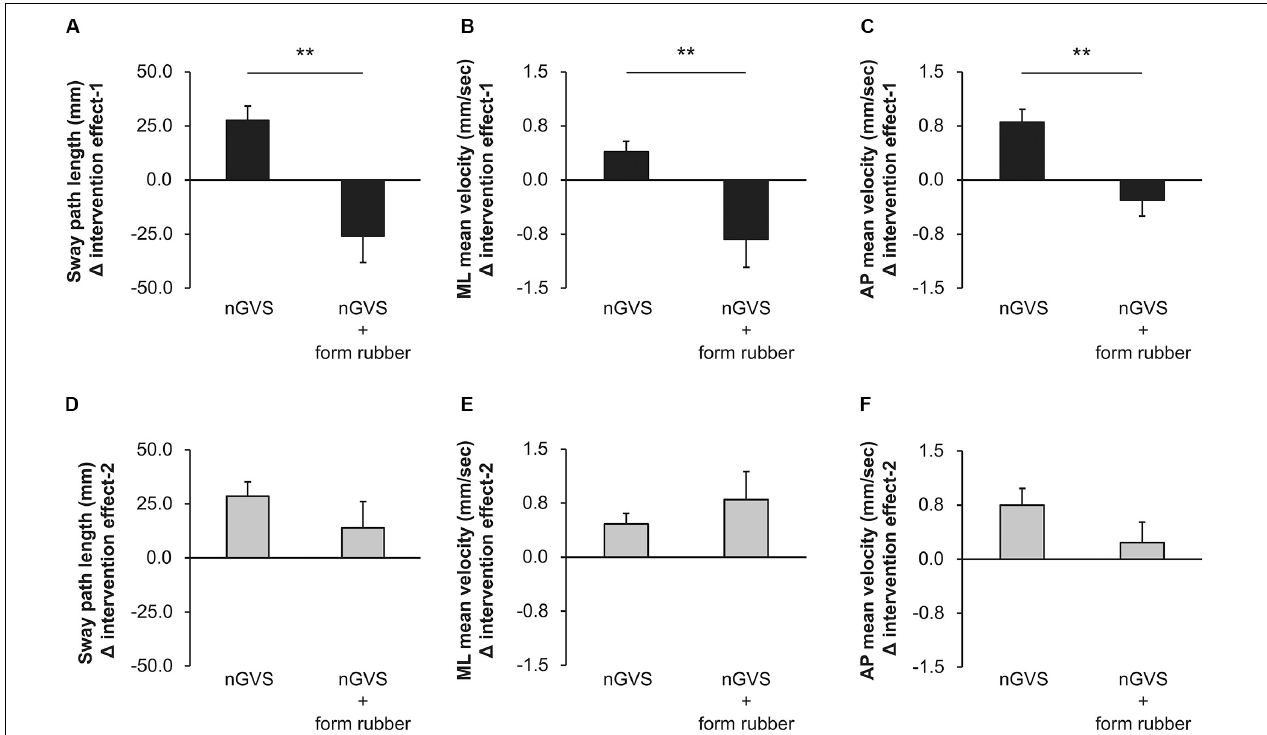
FIGURE 4 | Values of the intervention effect for each condition. (A) Intervention effect-1 of sway path length. (B) Intervention effect-1 of ML mean velocity. (C) Intervention effect-1 of AP mean velocity. (D) Intervention effect-2 of sway path length. (E) Intervention effect-2 of ML mean velocity. (F) Intervention effect-2 of AP mean velocity. Error bars indicate SE. ** p < 0.01. TABLE 3 | The COP sway values in Experiment 2. Pre Intervention-1 Intervention-2 Intervention-3 Post-1 Post-2